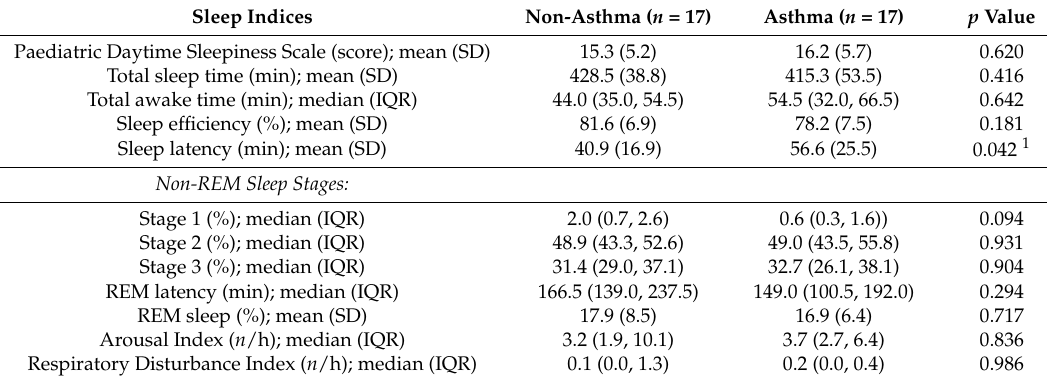
Table 2. Sleep quantity and quality in children with and without asthma, referred for an overnight polysomnography.